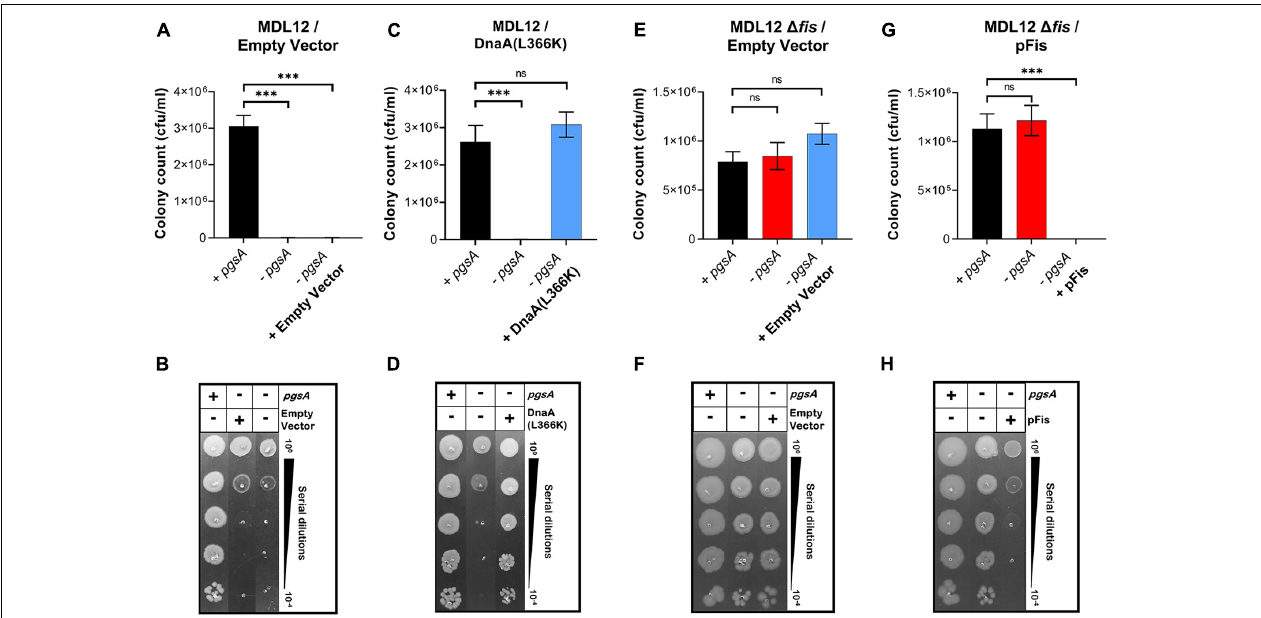
FIGURE 7 | Lack of fis in cells deficient in phosphatidylglycerol (PG) synthesis permits growth. (A,B) Viability of MDL12 cells carrying empty vector with 1 mM IPTG for the expression of pgsA (black), no inducer control (red), and 0.2% Arabinose control (blue) in M9+CAA+Glu media. (C,D) Viability of MDL12 cells carrying plasmid for DnaA(L366K) with 1 mM IPTG for the expression of pgsA (black), no inducer control (red), 0.2% Arabinose for DnaA(L366K) (blue) in M9+CAA+Glu media. (E,F) Viability of MDL12 fis-null cells carrying empty vector with 1 mM IPTG for the expression of pgsA (black), no inducer control (red), and 0.2% Arabinose control (blue) in M9+CAA+Glu media. (G,H) Viability of MDL12 fis-null cells carrying plasmid for Fis (pFis) with 1 mM IPTG for the expression of pgsA (black), no inducer control (red), and 0.2% Arabinose for Fis (blue) in M9+CAA+Glu media. Viability is expressed in cfu/ml and presented on a linear scale. Data are means ± SEM of at least three independent experiments. ∗∗∗ p < 0.001, ns p > 0.05 in one-way ANOVA with Dunnett’s multiple comparison